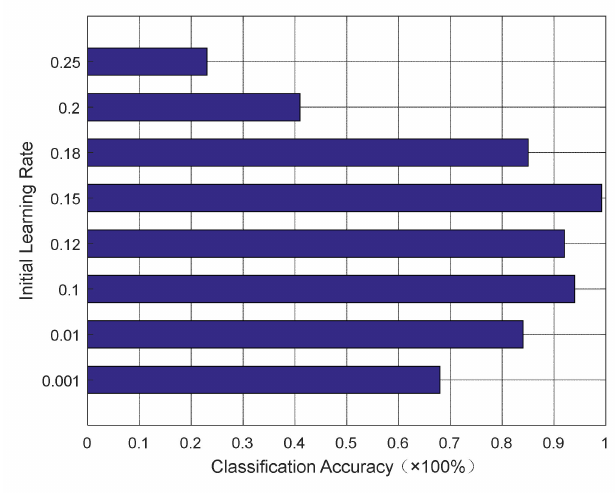
Figure 7. The influence of initial learning rates on the accuracy of MCNN.